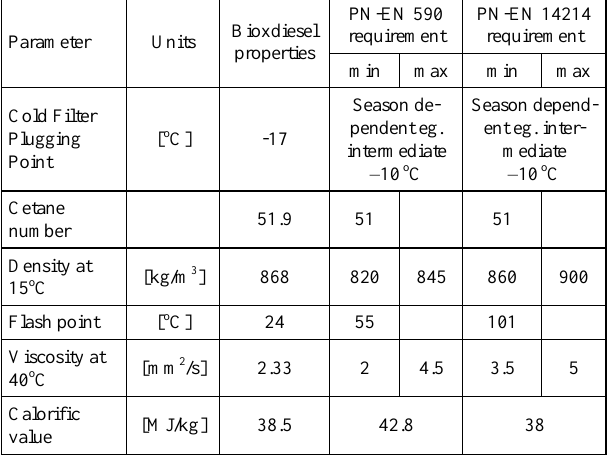
Table 3. Selected quality properties of the Bioxdiesel fuel compared with standard Diesel (PN-EN 590) and FAME (PN-EN 14214) requirements Parameter